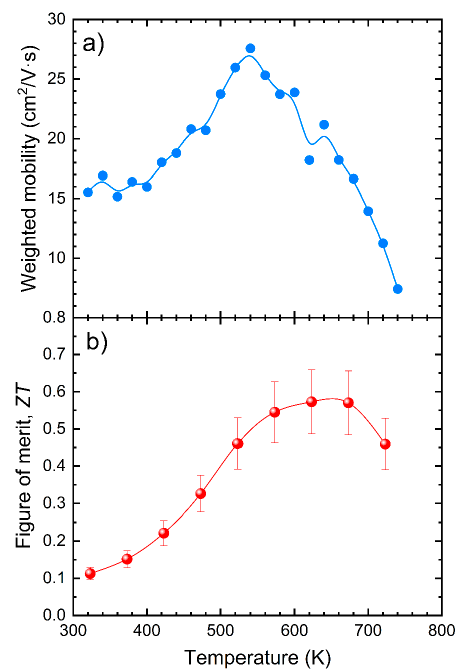
Figure 6. ( a )Weightedmobilityand( b )thermoelectricfigureofthemeritforthearc-meltedAgSbTe 2 compound. Figure 6. ( a ) Weighted mobility and ( b ) thermoelectric figure of the merit for the arc-melted AgSbTe 2 compound. Overall, the figure of merit (Figure 6b) reaches a non-negligible value of 0.6 at 680 K, following the increase of the Seebeck coefficient, despite the reduced electrical